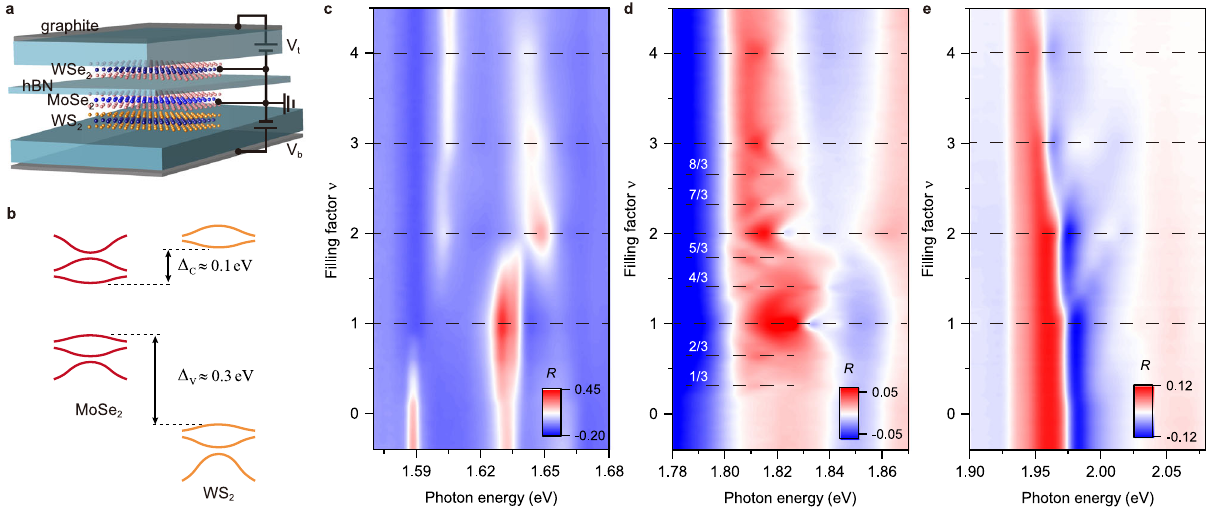
Fig. 1 | Correlated insulating states in MoSe 2 /WS 2 moiré heterobilayers. a Schematic illustration of a dual-gated MoSe 2 /WS 2 moiré heterobilayer with an integratedWSe 2 monolayersensor separated bybilayer hBN. Voltage V t and V b are applied to the top and bottom hBN-graphite gates, respectively. Both the moiré heterobilayerandthesensoraregrounded. b MoSe 2 /WS 2 moiréheterobilayerhasa type-I band alignment with Δ c ≈ 0.1 eV and Δ v ≈ 0.3eV. c – e Re fl ectance contrast